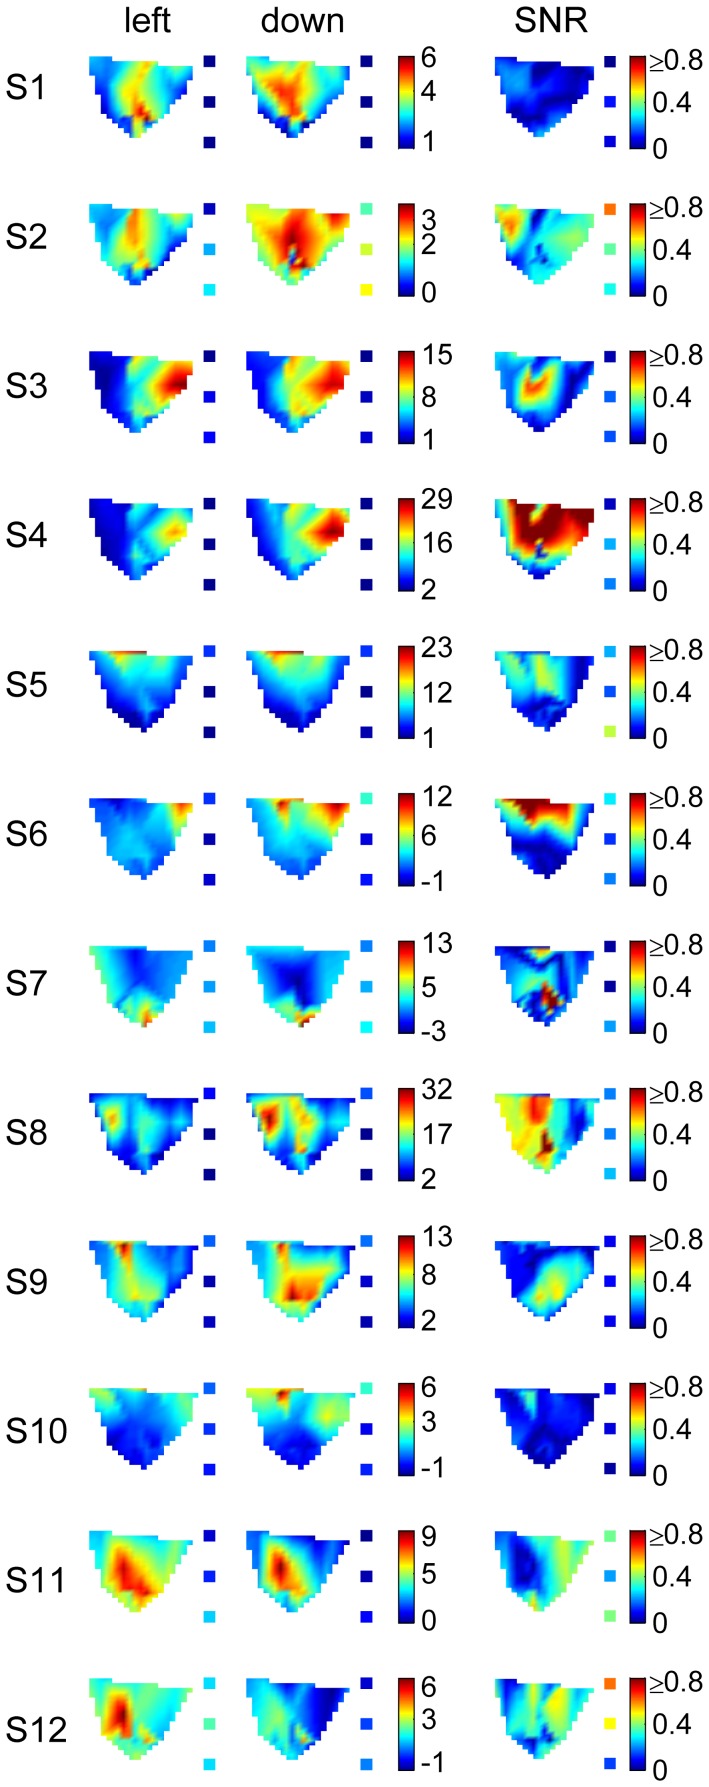
Topographies for each subject around movement end.Left and middle column: Interpolated color-coded amplitudes (in µM*mm) of average hemodynamic response (HbO, acausal filter) for left and downward movements, right column: interpolated signal-to-noise ratios (color-coding equal for all subjects). The small insets adjacent to each topography show the color-coded amplitudes of the hemodynamic responses averaged across trials and channels above ipsilateral-prefrontal, ipsilateral-sensorimotor and ipsilateral-occipital brain areas (from top to down, ipsilateral channels with source-detector distances <5.2 cm).